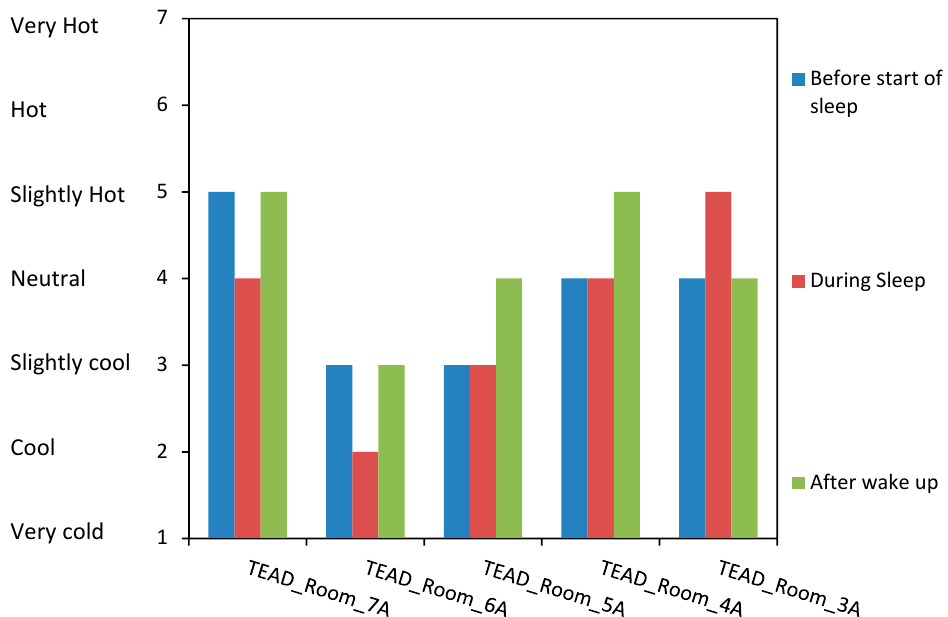
Figure 16. Variation in overall thermal sensation at different operating power.